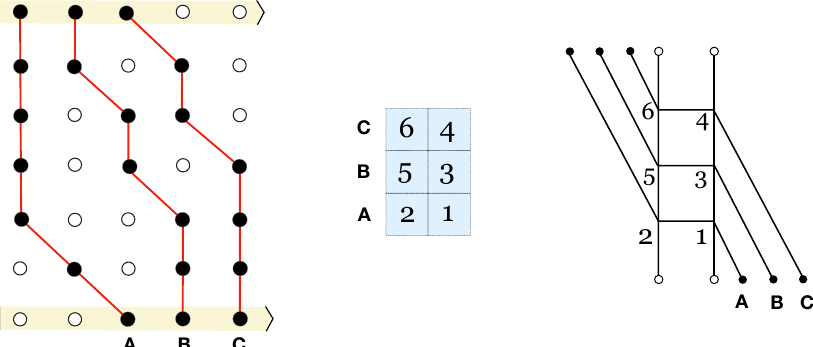
Figure 1 . Left: one possible stampede of m = 3 magnons with n = 2 empty sites. The initial state (bottom) is | ◦ ◦ • • •i , the final state (top) is | • • • ◦ ◦i . Red lines are the trajectories of the magnons. Center: young tableaux associated with the stampede. Right: graph associated to the stampede: when one magnon A, B, C crosses a vertical line, it hops one step left. The vertices are ordered according to the stampede on the left